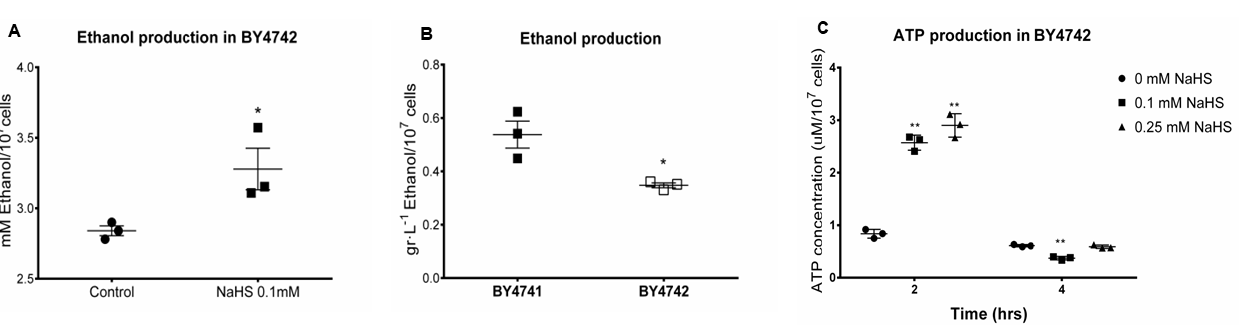
Figure 5. Exogenous and endogenous H 2 S on yeast cells induce ethanol production and ATP synthesis. ( A ) BY4742 yeast cell cultures were treated with NaHS 0.1 mM, and seven hour later, supernatants were collected. Ethanol production was measured in vitro at 37 ◦ C. Closed circles, untreated cells; closed squares, NaHS 0.1 mM. Unpaired t * p = 0.04. ( B ) Yeast cell cultures of the strains BY4741 and BY4742, supernatants were collected at 24 h. Ethanol production was measured in vitro at 37 ◦ C. Closed squares, BY4741; open squares, BY4742. Unpaired t * p = 0.02. ( C ) Yeast cell cultures in exponential phase were treated with NaHS 0.1 and 0.25 mM. Two and four hours later, whole-cell extracts were lysated, and ATP was quantified. ATP production was measured in vitro at 37 ◦ C. Closed circles, untreated cells; closed squares, NaHS 0.1 mM; closed triangles, NaHS 0.25 mM. One-way ANOVA ** p < 0.001.